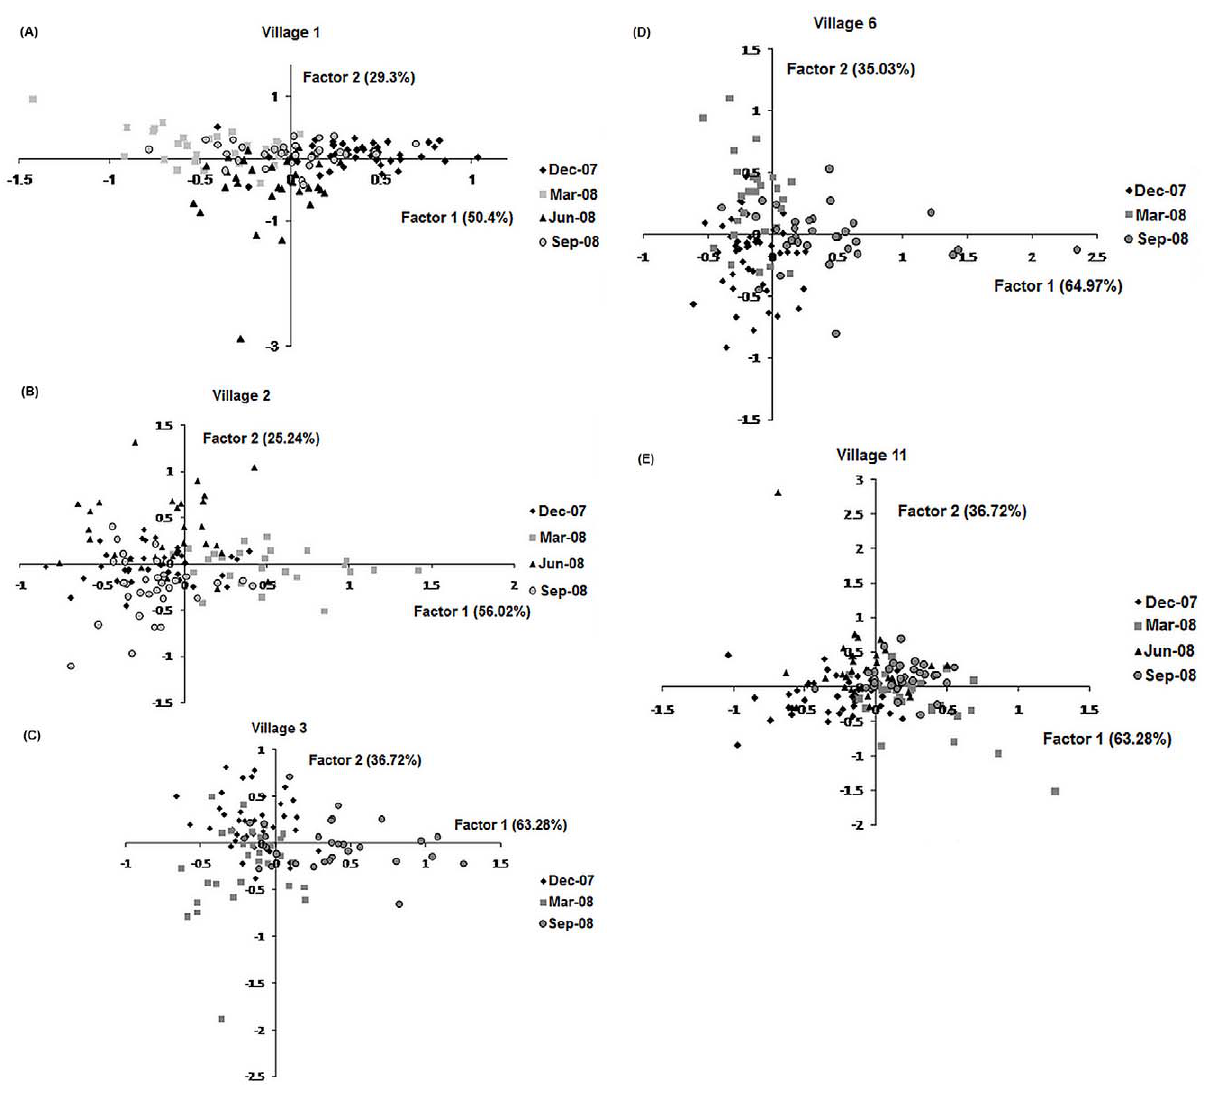
Figure 2. Temporal differences in population structure in Aedes(Stegomyia)aegypti (L.) in a complex of five eastern Thai villages, identified with Factorial Correspondence Analysis ((A) Village 1; (B) Village 2; (C) Village 3; (D) Village 6 and (E) Village